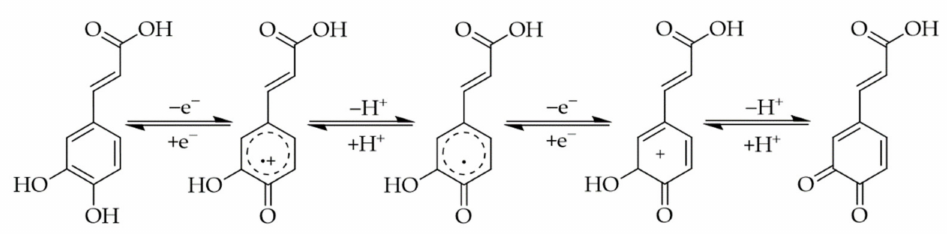
Figure 3. Structural representation of the o -quinone formation from CA.